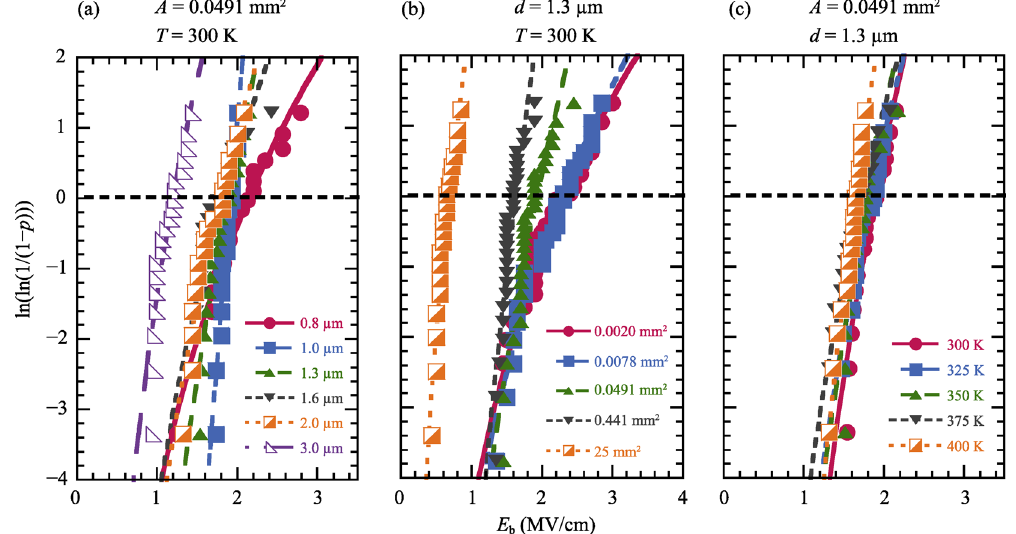
Fig. 2 Weibull failure estimation of dielectric breakdown electric field ( E b ) of PLZT films in different film thickness (a), electrode area (b), and under various temperature (c) ( R >